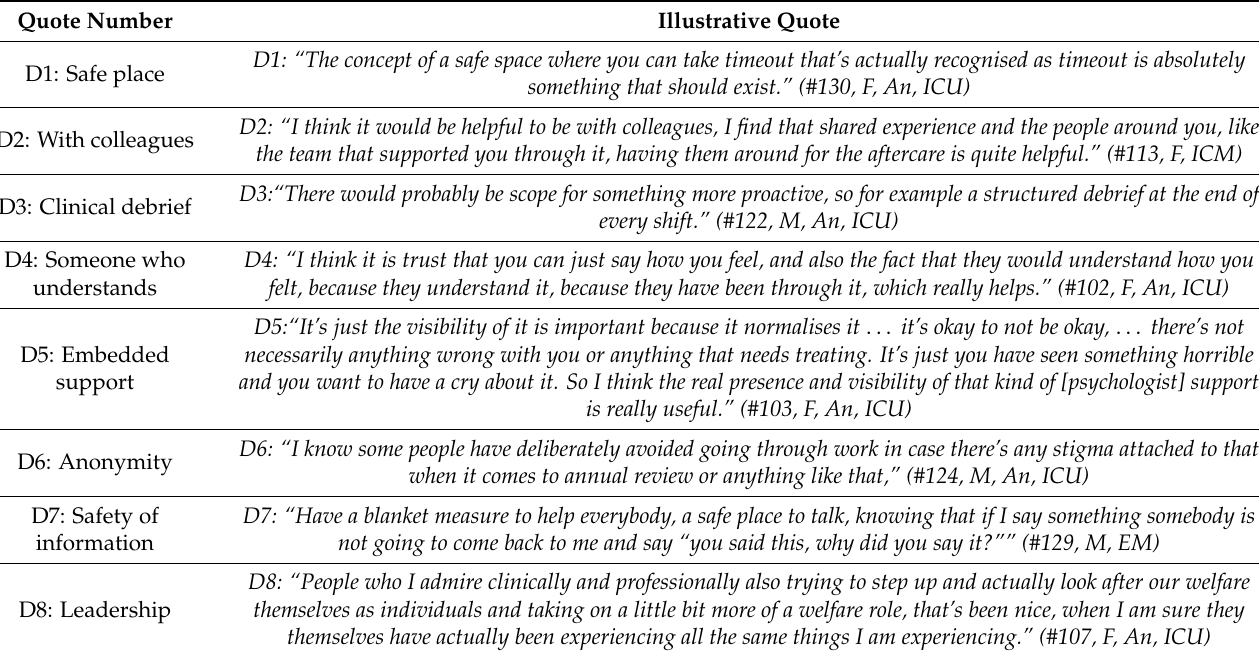
Table 7. Illustrative quotes for Improving Engagement